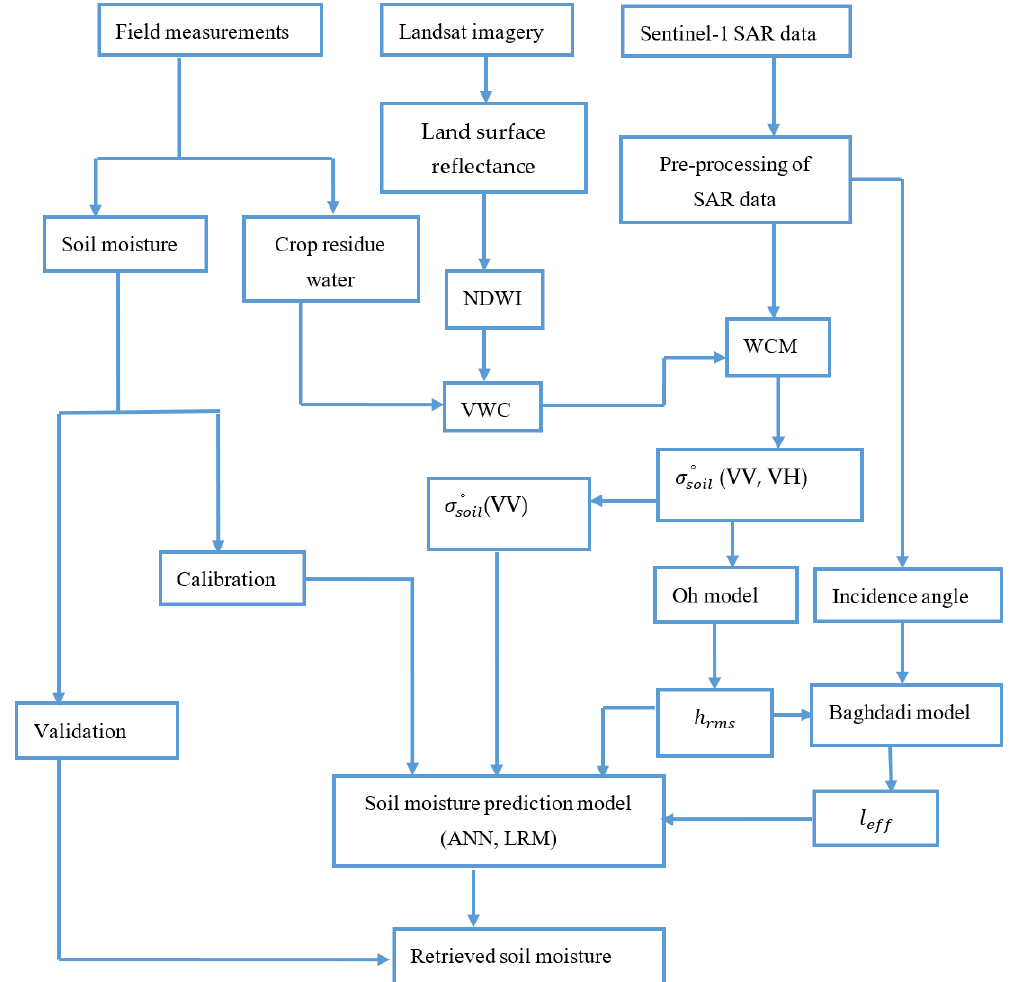
Figure 2. Schematic diagram shows the flow of soil moisture estimation. NDWI-normalized difference wetness index, VWC-vegetation water content, WCM- water cloud model, VV- vertical transmit and vertical receive polarization, HV- horizontal transmit and vertical receive polarizations, ANN-artificial neural network, and LRM-linear regression model.